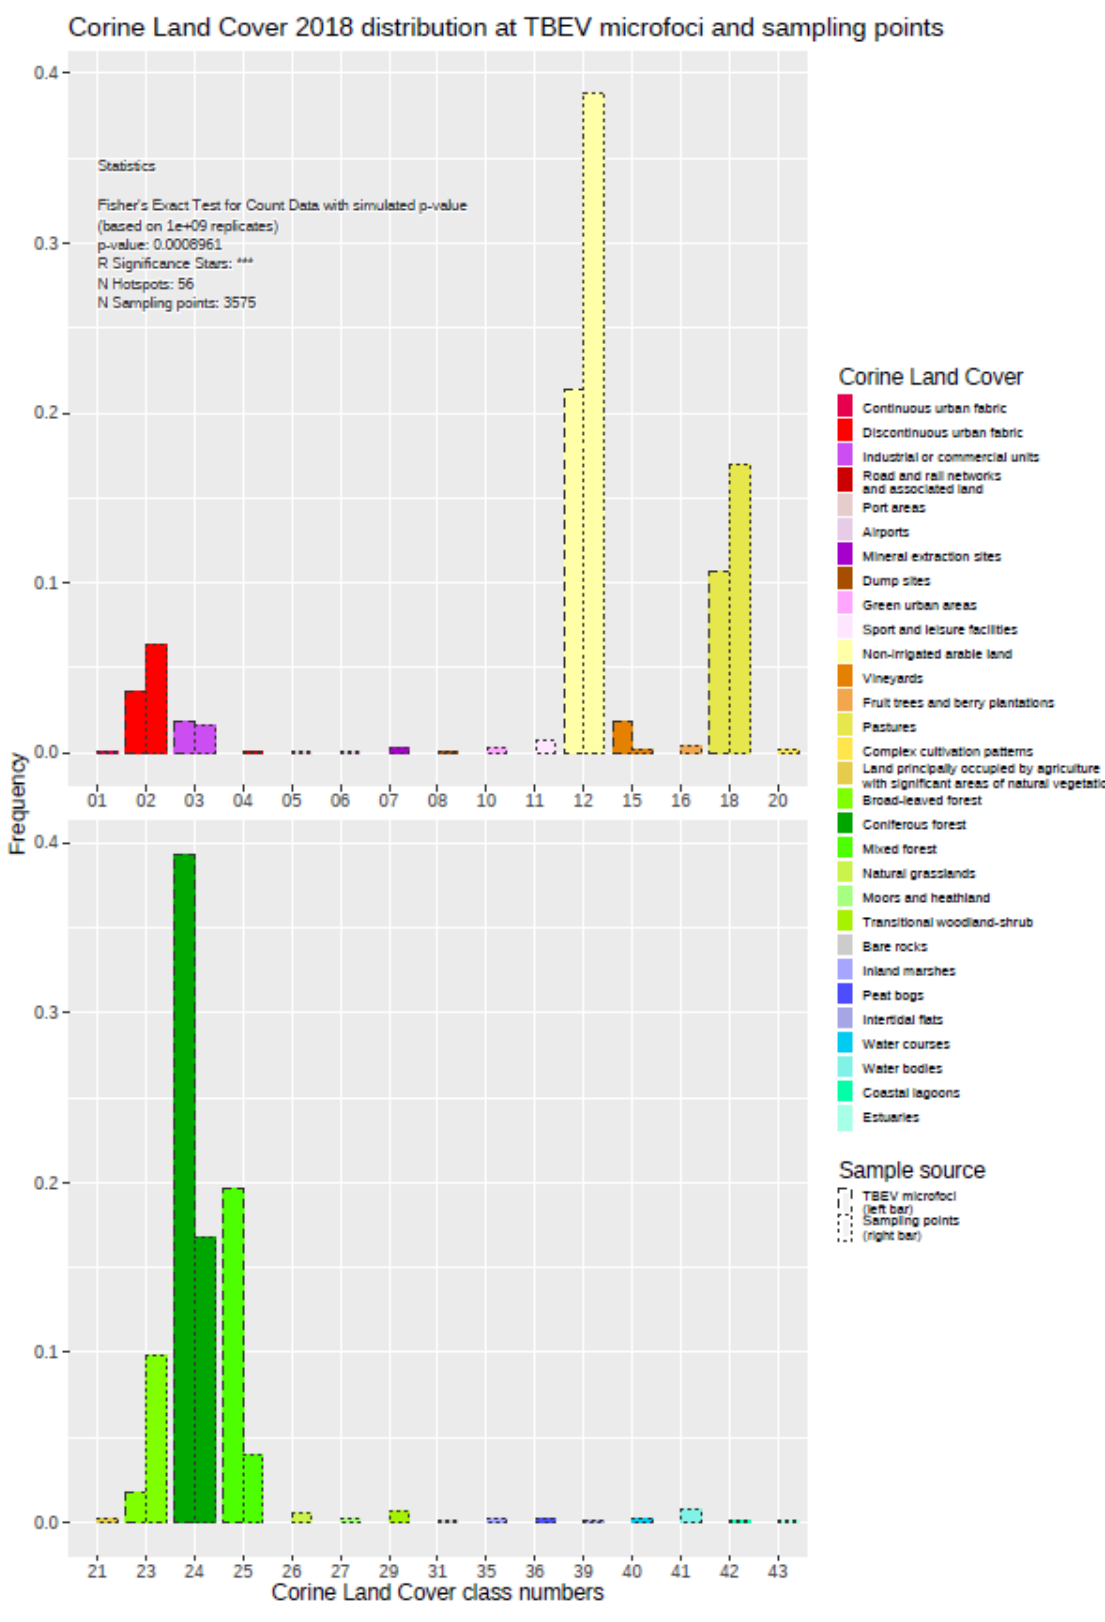
Figure 4. Distribution of different land cover types around the TBEV microfoci compared with the control sampling points. The results of Fisher’s Exact Test are displayed in the inset.